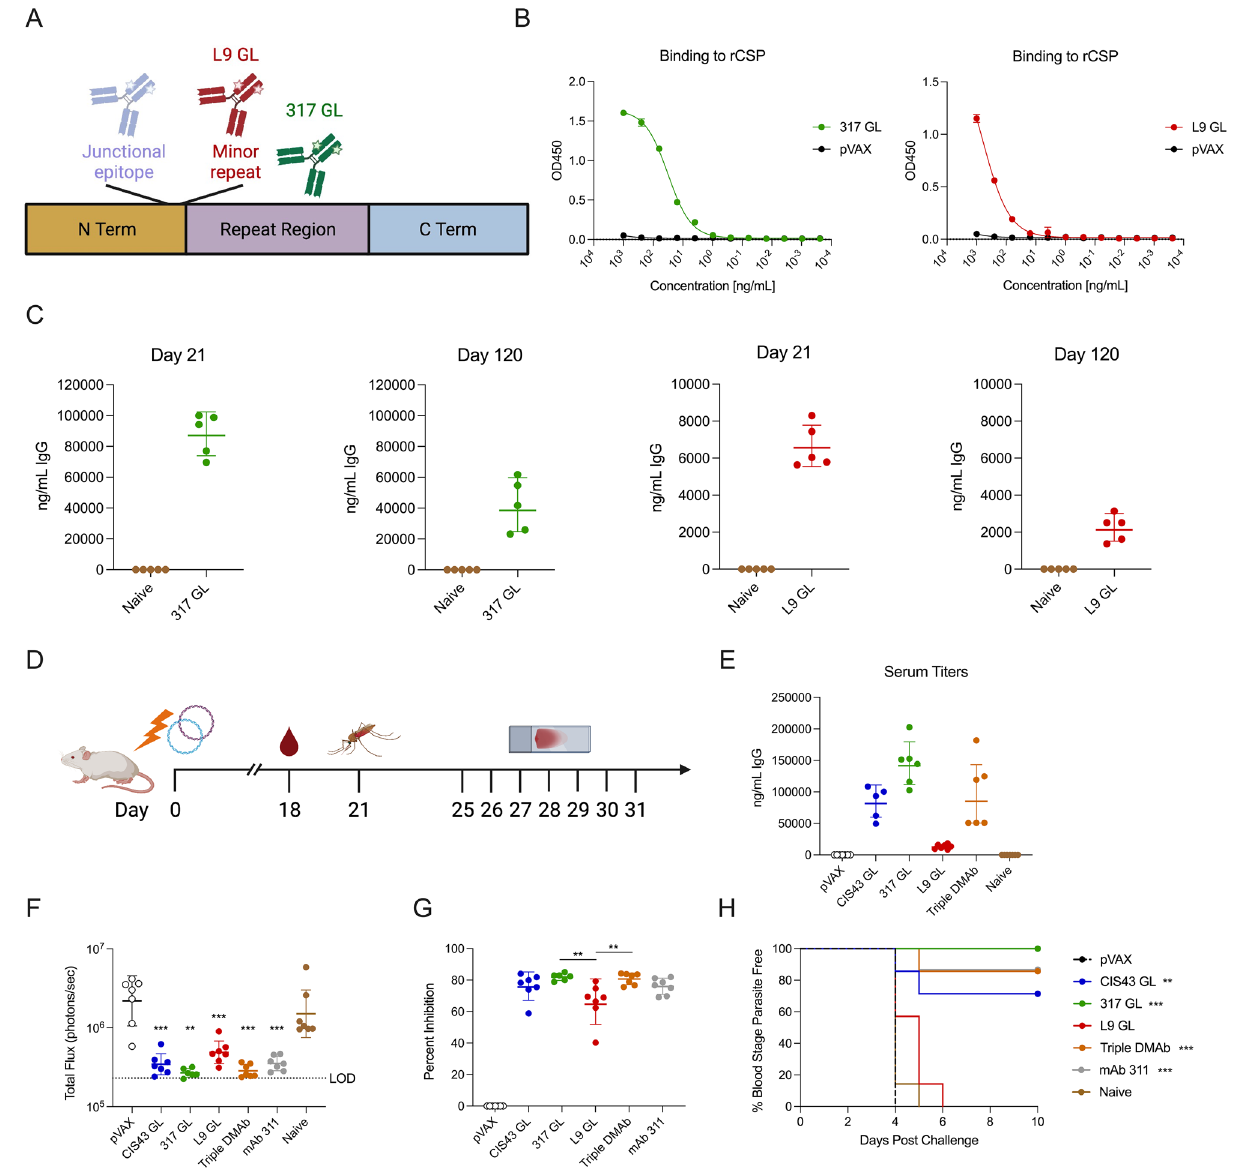
Figure 2. Multiple anti-CSP GL DMAbs protect in mosquito bite challenge. ( A ) Schematic showing 317 GL and L9 GL binding domains on CSP. ( B ) Binding ELISA of pooled supernatants of 317 GL (left) and L9 GL (right) harvested from Expi293F transfection to rCSP (mean ± SD). ( C ) In vivo expression of 317 GL (left two panels) and L9 GL (right two panels) in BALB/c mice at the peak expression timepoint Day 21 through Day 120. Mice were immunized with 100 µg CIS43 intramuscularly in the tibialis anterior with CD4+/CD8+ T cell depletion (n = 5 mice/group; geometric mean ± geometric SD). ( D ) Experimental layout of challenge. Mice were immunized with CIS43 GL (100 µg), 317 GL (100 µg), L9 GL (200 µg) or a cocktail (“Triple DMAb”; CIS43 GL 50 µg, 317 GL 50 µg, L9 GL 100 µg) and challenged 21 days post administration with mosquitos carrying PbPfLuc parasites. Positive control recombinant mAb 311 was administered 16 h prior to challenge. Blood smears for blood stage parasitemia were performed from days 4–10 post challenge. ( E ) Serum titers of DMAb 18 days post administration. ( F ) Total flux quantified by IVIS (geometric mean ± geometric SD) ( G ) Percent inhibition of liver infection relative to infection of naive control infected mice (geometric mean ± geometric SD). ( H ) Percent of blood stage parasite free mice, determined through blood smears (n = 6–7 mice/group). Statistical analyses were done using a two-tailed Mann–Whitney test with comparisons relative to naïve infected ( F , H ). One-way ANOVA adjusted for multiple comparisons between all treatment groups ( G ). **p < 0.01, ***p <